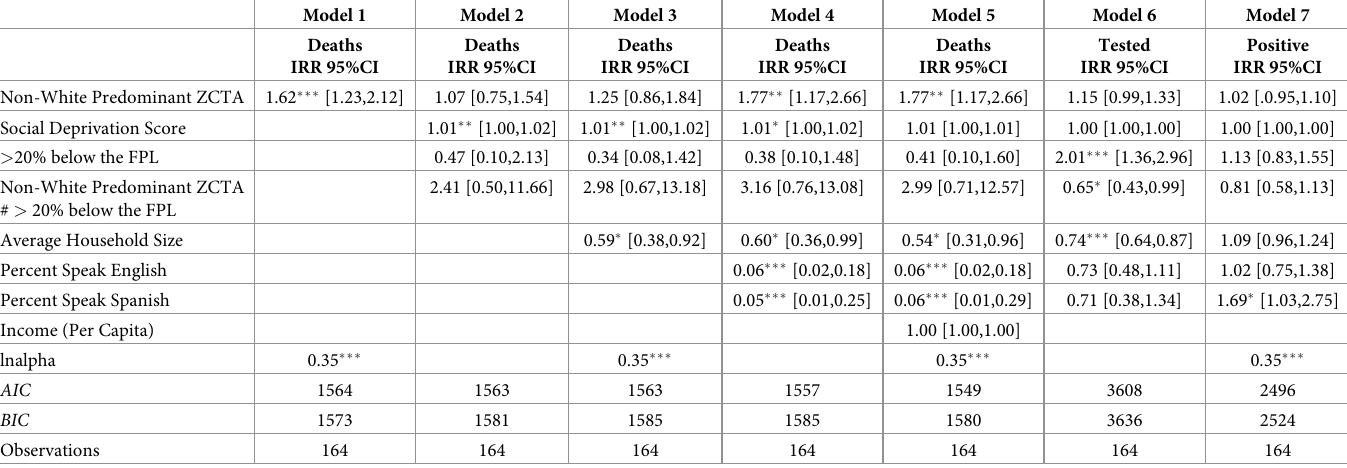
Table 3. Negative binomial regression model